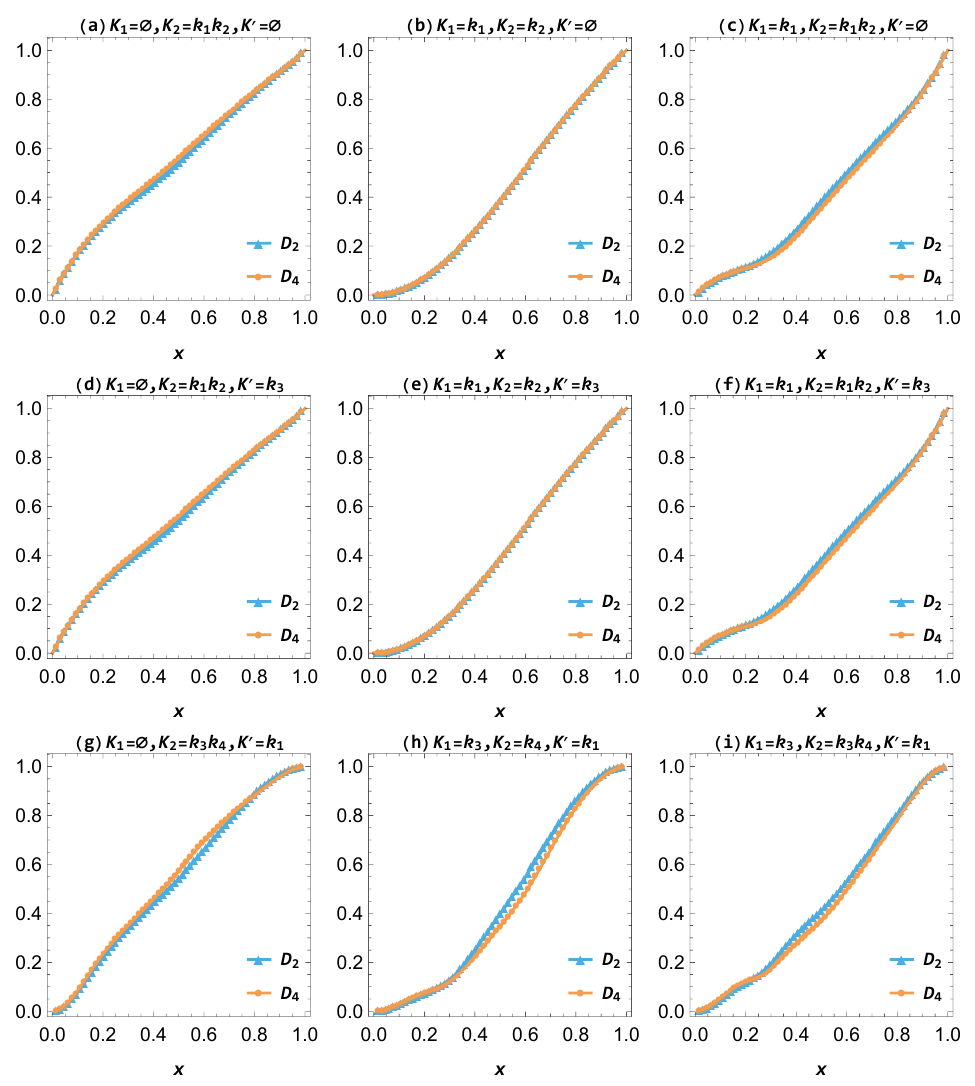
Figure 7 . Checks of the first conjecture (2.14) (the first row), the second conjecture (2.19) (the second row), and the third conjecture (2.23) (the third row) in the nearest-neighbor coupled bosonic chain. The symbols in each panel are numerical results for the normalized Schatten distance ( ρ ; ρ ) with n = 2 , 4 , which are from the wave function method. In D n ≡ D bos A,K 1 ∪ K 0 , ρ A,K 2 ∪ K 0 A,K 0 n the first and the second rows, the solid lines are the analytical conjectured results from the subsystem mode method in the free bosonic chain. In the third row, the solid lines are the numerical conjectured results in the nearest-neighbor coupled bosonic chain. We have set m = 10 − 6 , ( k and ( k ) = (1 , 2) . For the analytical results in the first and second rows we have set L = + ∞ , 3 , k 4 and for all other cases we have set L = 64